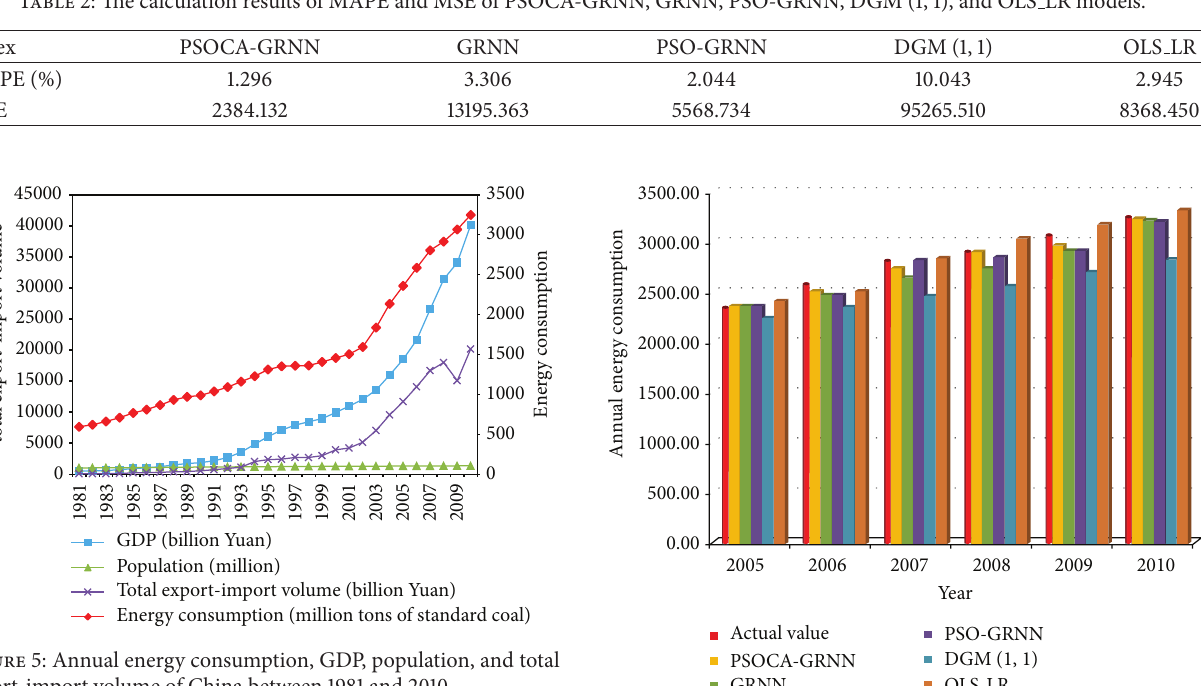
and MSE values of PSOCA-GRNN, GRNN, PSO-GRNN, DGM (1, 1), and OLS LR models are listed in Table